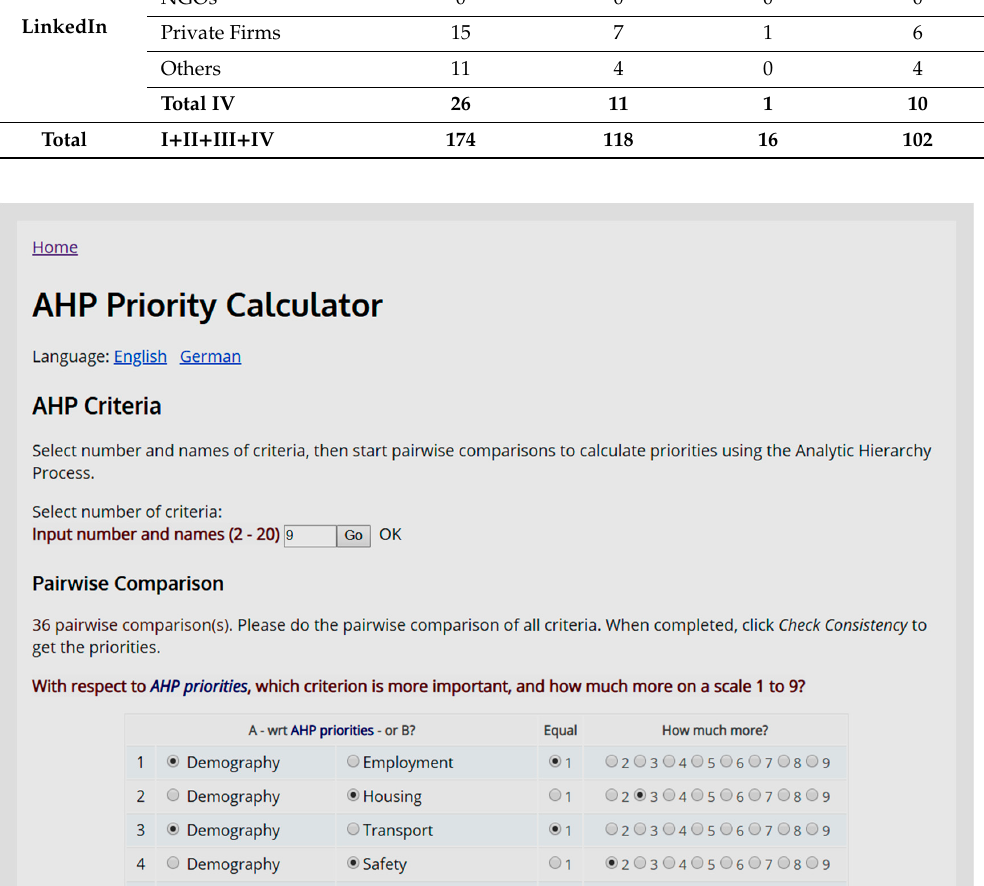
Figure 2. AHP ‐ OS priority calculator. Figure 2. AHP-OS priority